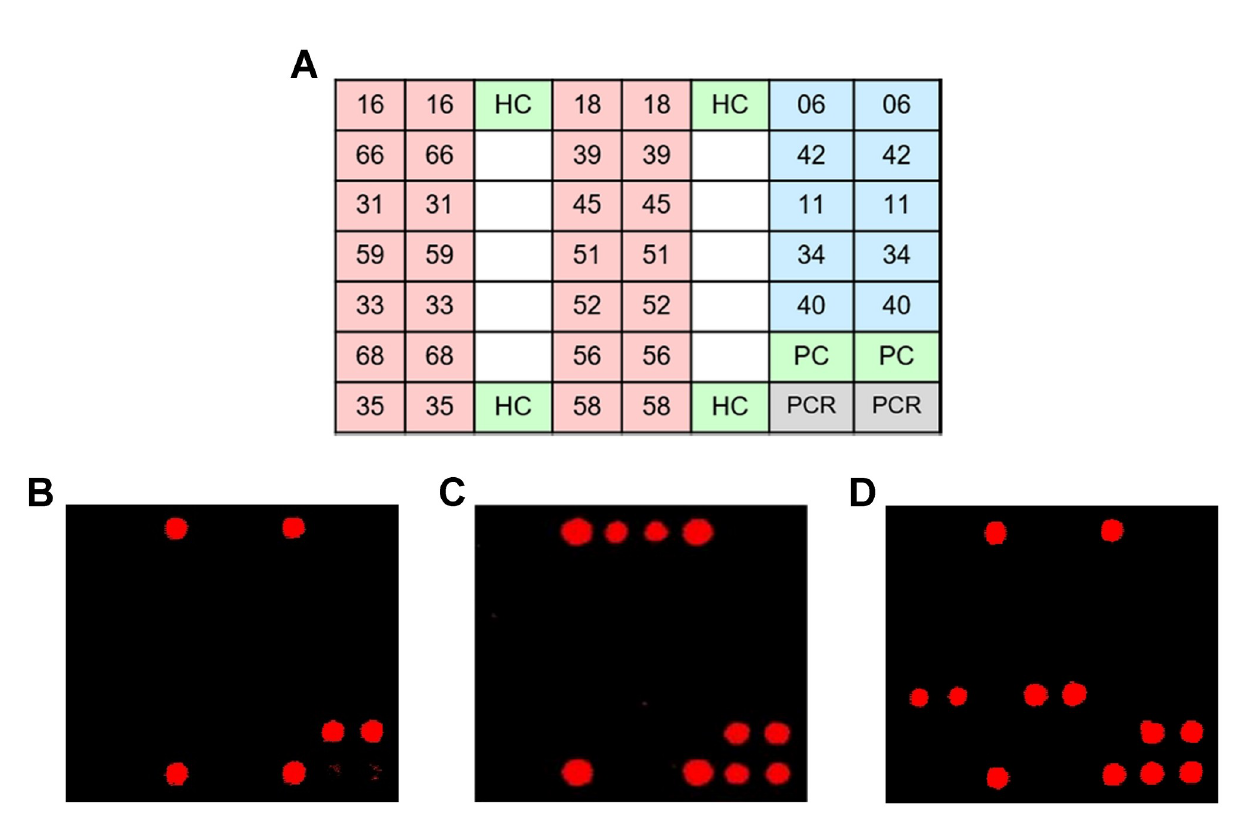
Fig 1. HPV 9G DNA. (a) The findings of 19 HPV genotypes including 14 high-risk group (pink color) and 5 low-risk group (blue color), along with the hybridization control (HC), PCR internal control (PC), and HPV PCR screening (PCR) probes, were spotted. Representative scanning images of (b) negative control, (c) a single infection of HPV-18, and (d) dual infections of HPV-33 and